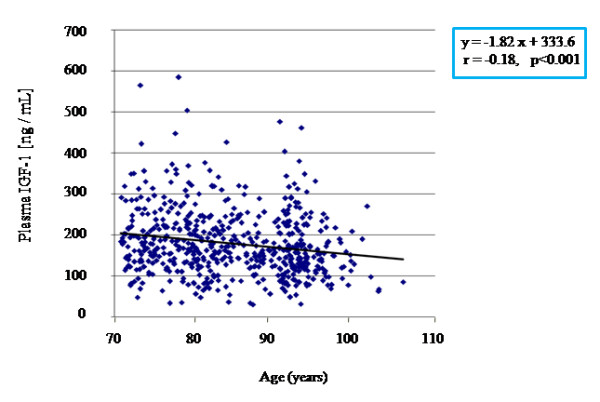
Age-related reduction of circulating IGF-1. Scatter-plot showing individual plasma IGF-1 levels measured by a dedicated ELISA kit, described in Methods. The superimposed line indicates the simple linear interpolation, whose equation and statistical significance are shown in the box on the graph. r: correlation coefficient.